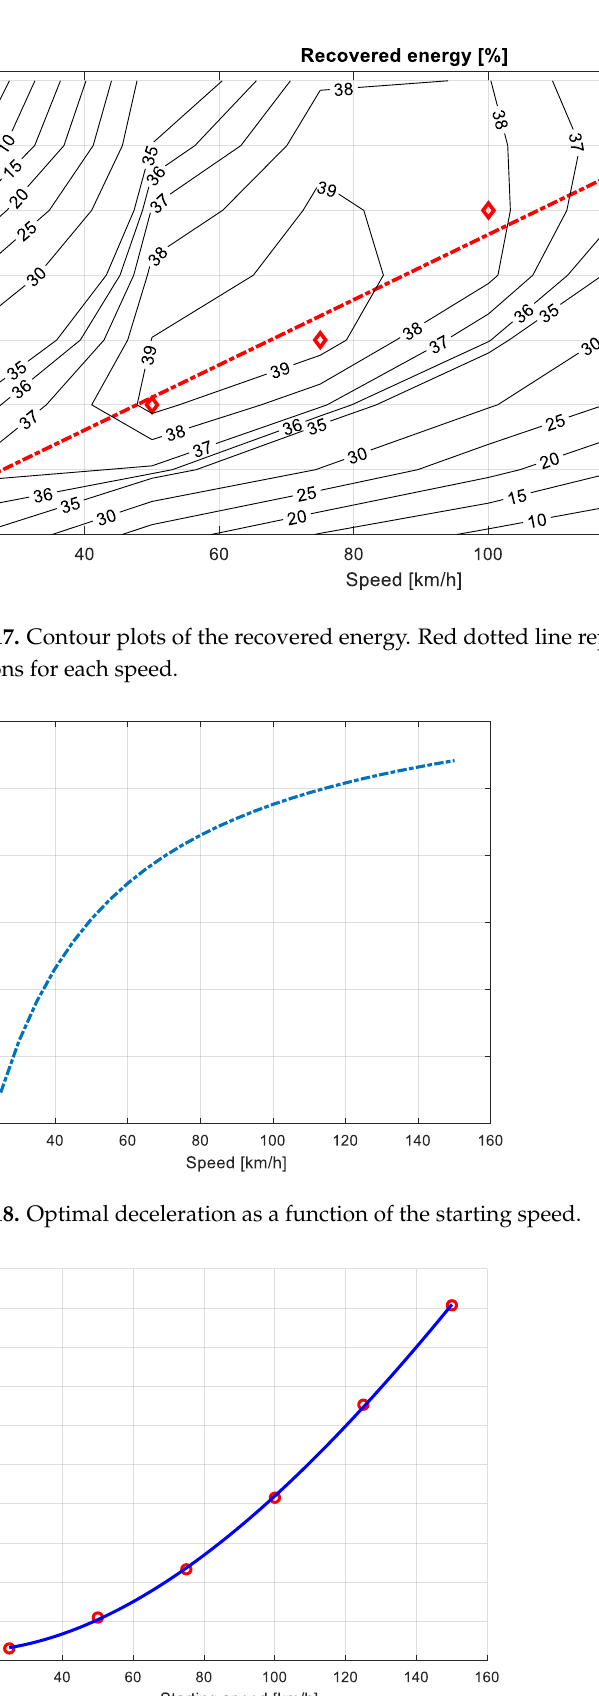
Figure 16. Percent of recovered energy at various starting speeds and stopping times, with contour plots. Results obtained with 8 steps in braking manoeuvre.